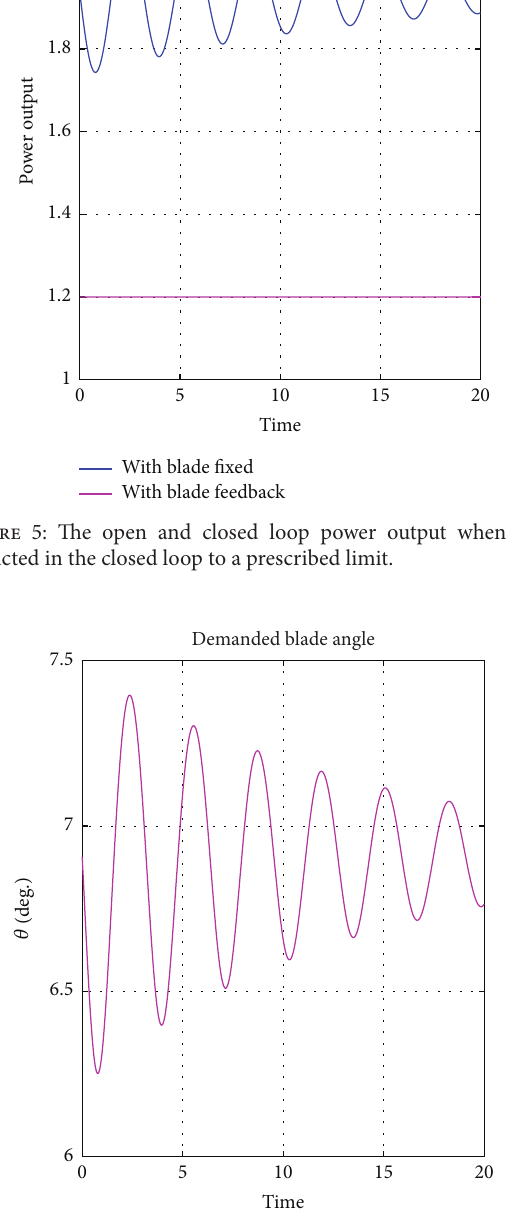
Figure 6: The open and closed loop demanded blade angle corre- sponding to Figure